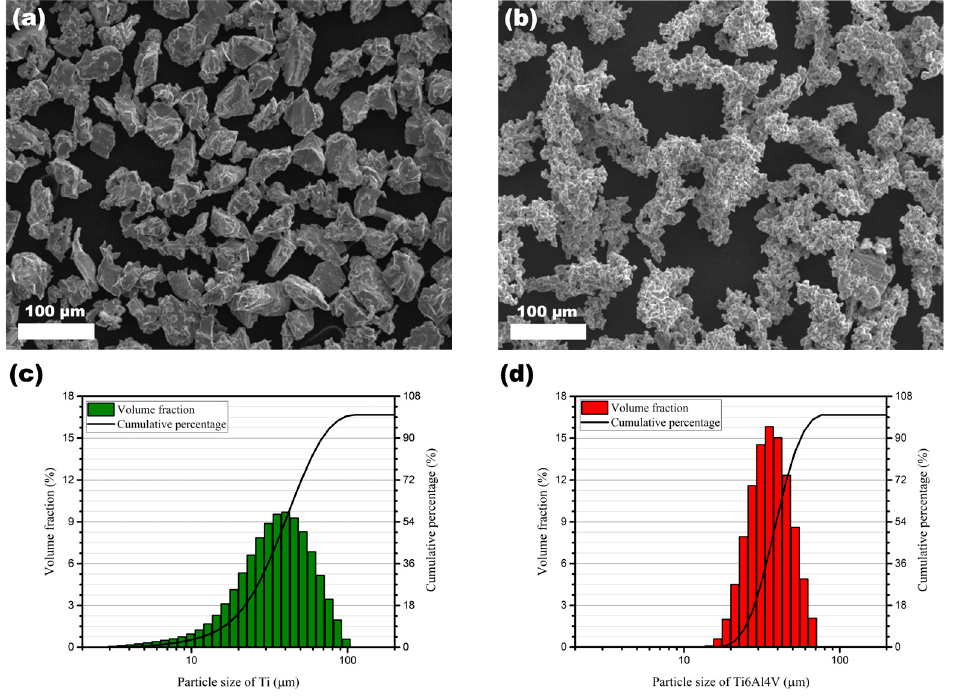
Figure 1. SEM images showing powders’ morphologies: ( a ) angular Ti, ( b ) spongy Ti64, and particle size distributions of ( c ) Ti and ( d ) Ti64.